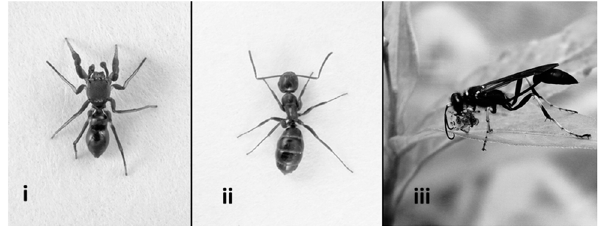
Figure 1. Ant-mimicking spider and two potential predators: i) Peckhamiapicata , ant-mimicking jumping spider; ii) Camponotus nearcticus , putative ant model and a predator; iii) Sceliphron caementarium , spider-hunting predatory wasp. (Figures not to scale. Ant and ant-mimic photos by J. Coddington, wasp photo by